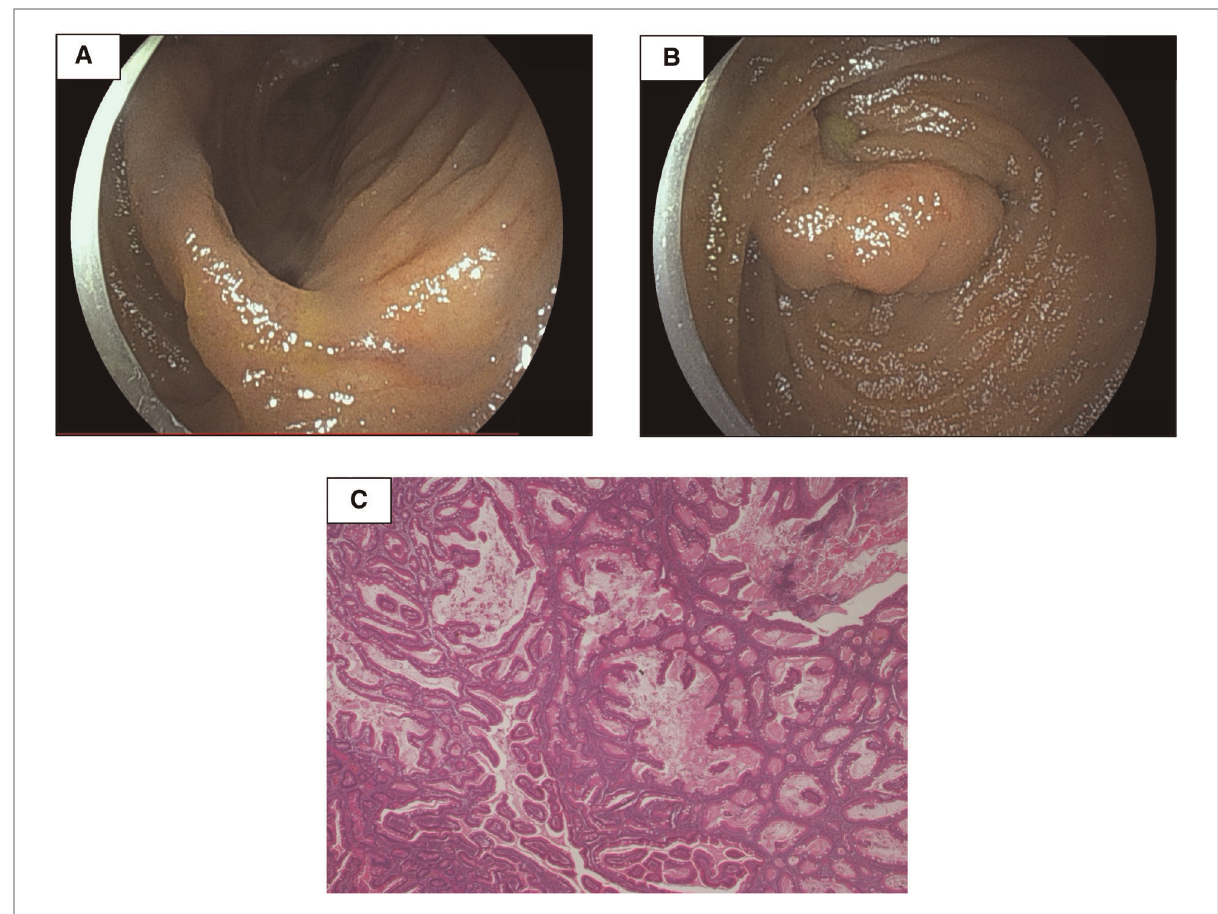
FIGURE 3 Double-balloon enteroscopy revealed two polyps with diameters of 20 and 30 mm ( A,B ). The pathological fi ndings were consistent with hamartoma ( C